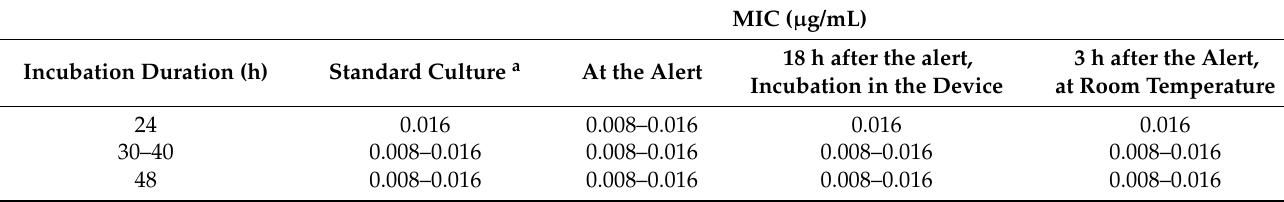
Table 16. Ciprofloxacin Etest MIC values of F. tularensis -positive blood cultures.